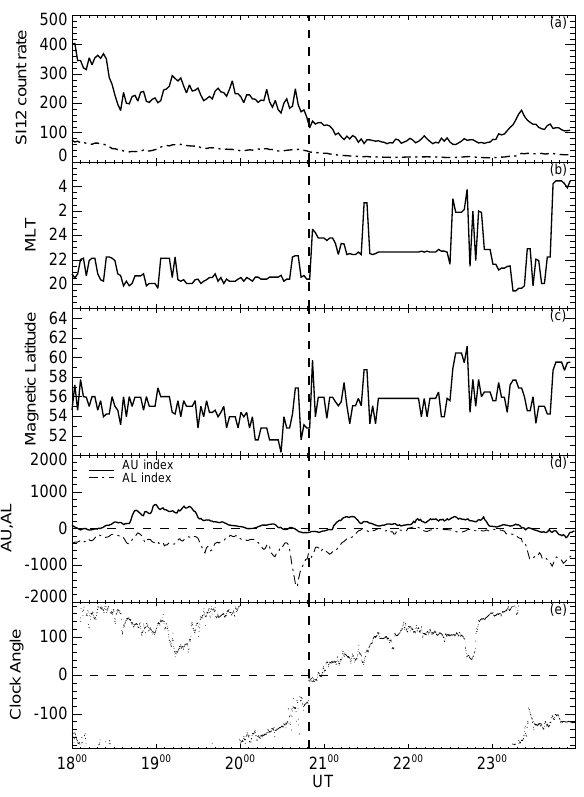
Fig. 8. (a) Maximum and mean brightness of a nightside portion of the auroral oval, this portion being outlined in Fig. 3. (b) The magnetic local time of the brightest pixel within this area (c) The magnetic latitude of the brightest pixel within the area (d) the AL and AU indices during the interval of interest (e) the clock angle measured by ACE lagged to the magnetopause. The vertical dashed line marks the onset of dual lobe reconnection as calculated from Fig.